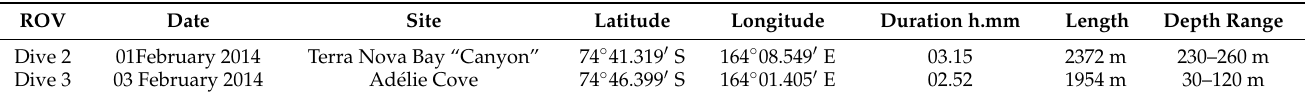
Table 2. Benthic surveys metadata. The table reports the technical information on the ROV surveys performed at Terra Nova